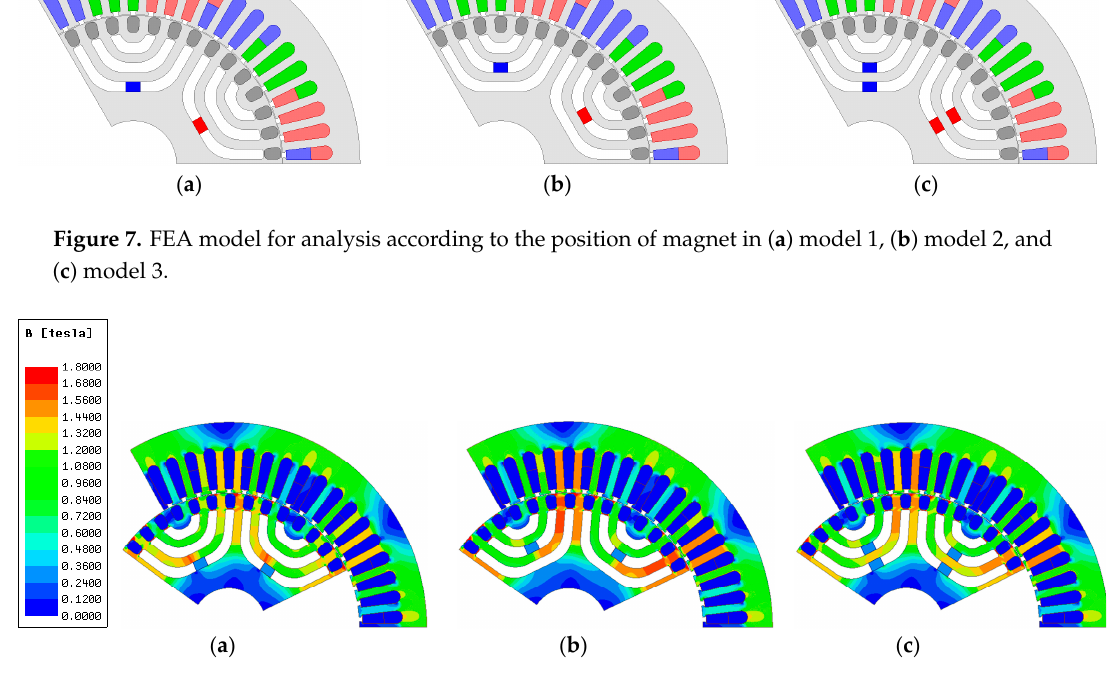
Figure 8. Electromagnetic analysis result using FEA according to the position of magnet in ( a ) model 1, ( b ) model 2, and ( c ) model 3 .